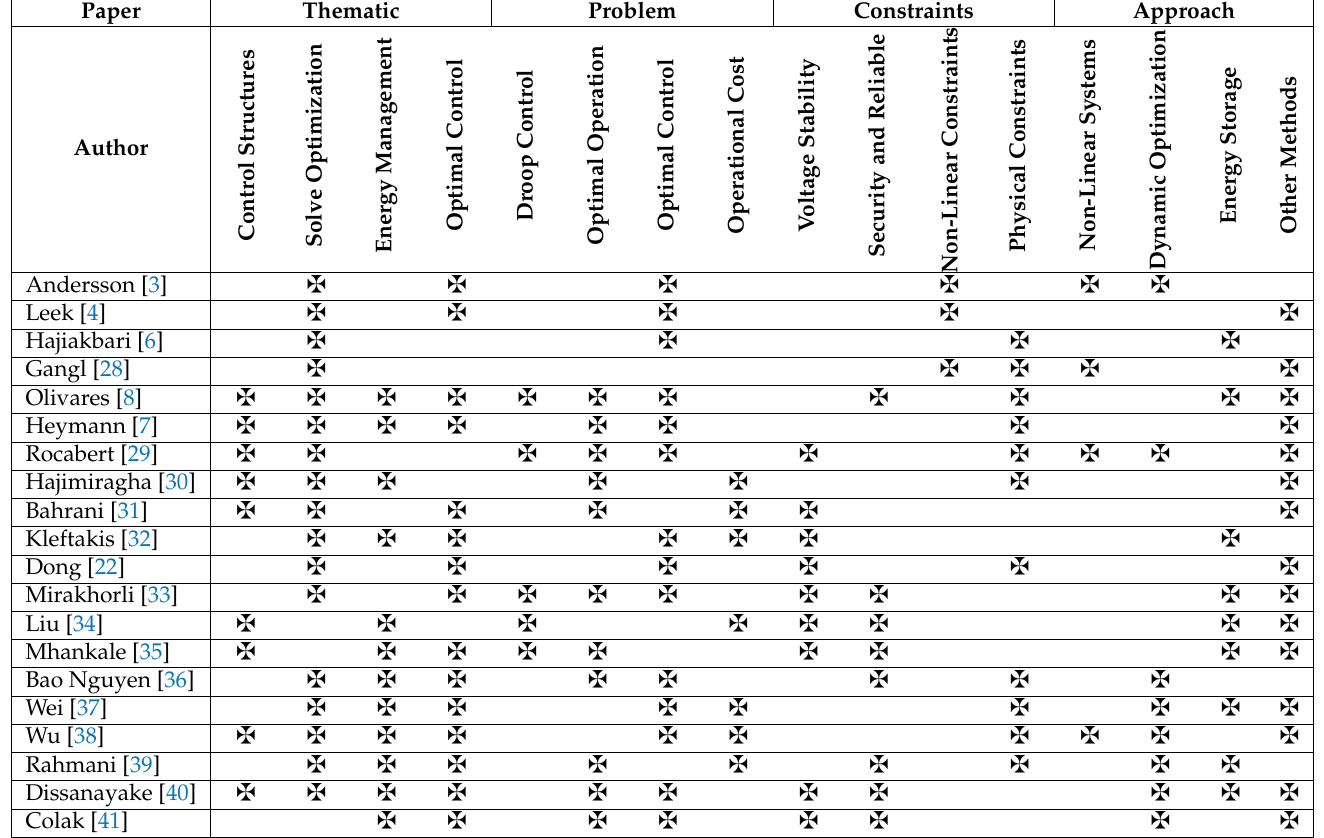
Table 2. State of the art optimal control smart substation summary. Problem Constraints